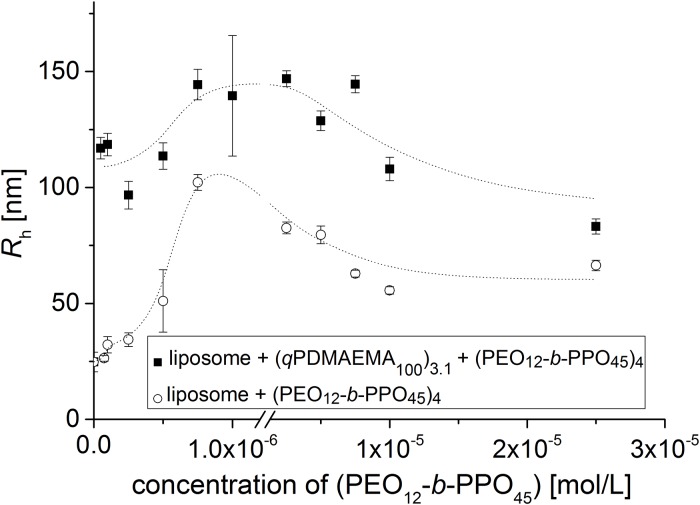
Course of size with varying “Glue” concentration.The hydrodynamic radii for the liposome/(PEO12-b-PPO45)4 polymer complexes and the liposome/(qPDMAEMA100)3.1/(PEO12-b-PPO45)4 polymer complexes at different (PEO12-b-PPO45) concentrations. The lipids concentration is 6.37 x 10−5 mol/L. For one data set, the concentration of the positive charges of (qPDMAEMA100)3.1 was held constant at 1.9 x 10−6 mol/L. Tris Buffer pH = 7, 20°C (lines are a guide to the eye).